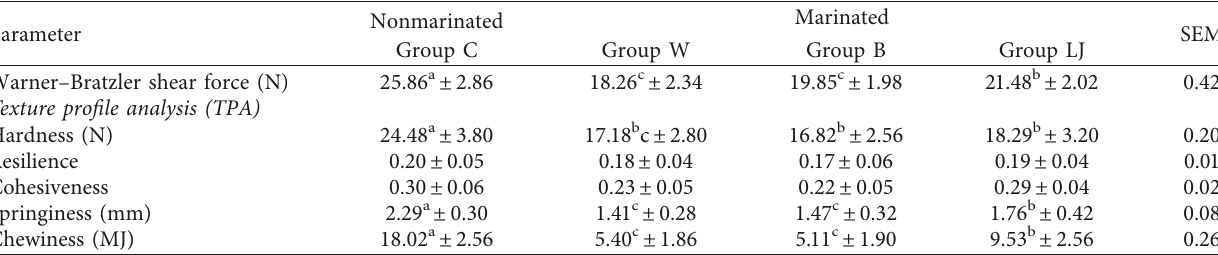
Table 3: Texture parameters (Warner–Bratzler test and texture profile analysis) of nonmarinated and marinated roasting breast muscles of slaughter pheasants.